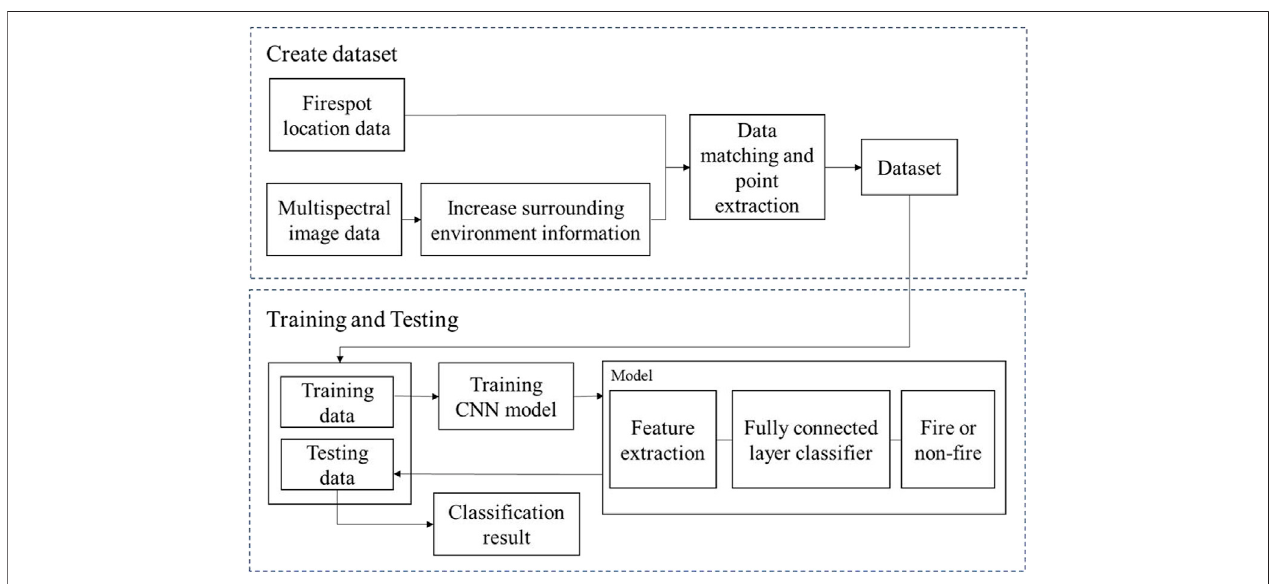
FIGURE 2 | The fl ow chartof the fi re detection solution.